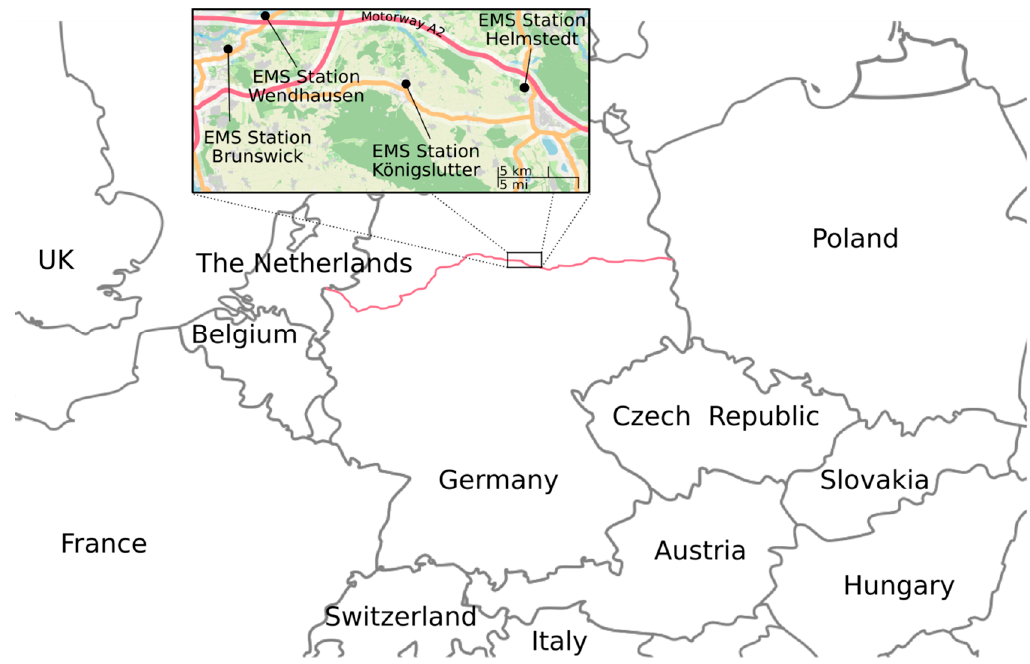
Figure 1. Locations of the recruiting rescue service stations in Germany. The red line shows the course of the A2 motorway, one of the most important east-west transport corridors between Eastern Europe and the Dutch seaports.